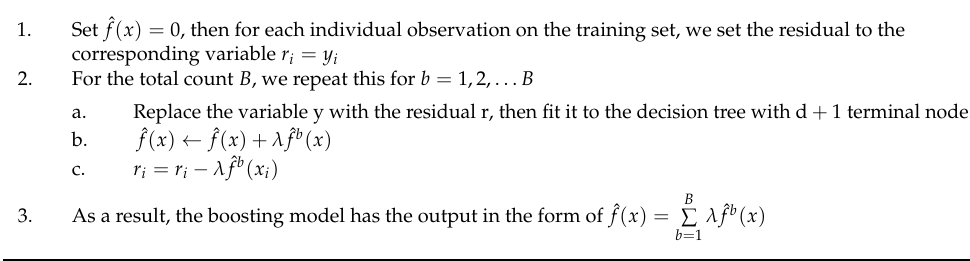
Algorithm 1. Tree boosting with XGBoost